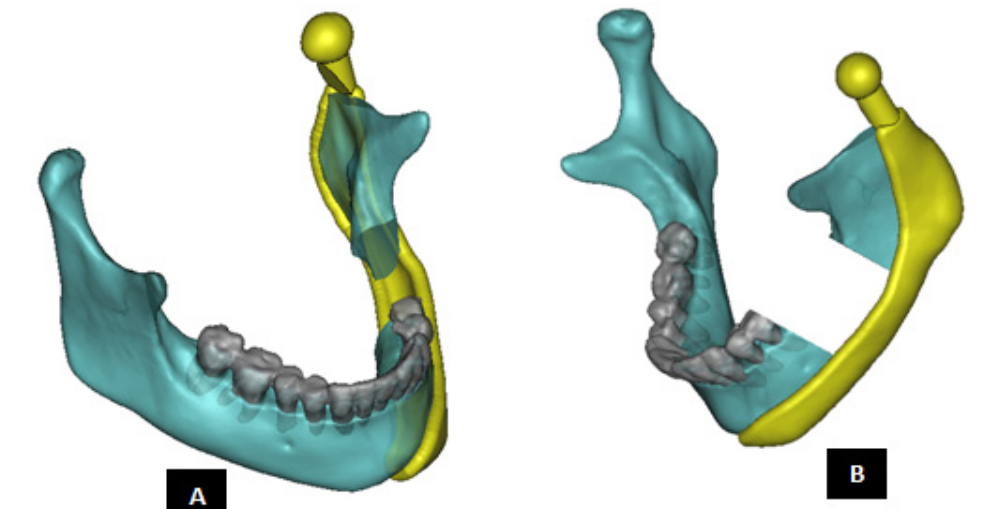
Figure 5. Shape outline of a custom-designed condylar/ramus prosthesis for the replacement of right TMJ of a patient. ( A , B ) Show lateral–anterior view and lateral–posterior view, respectively, of the prosthesis accurately conforming to geometric shape of patient’s mandible.